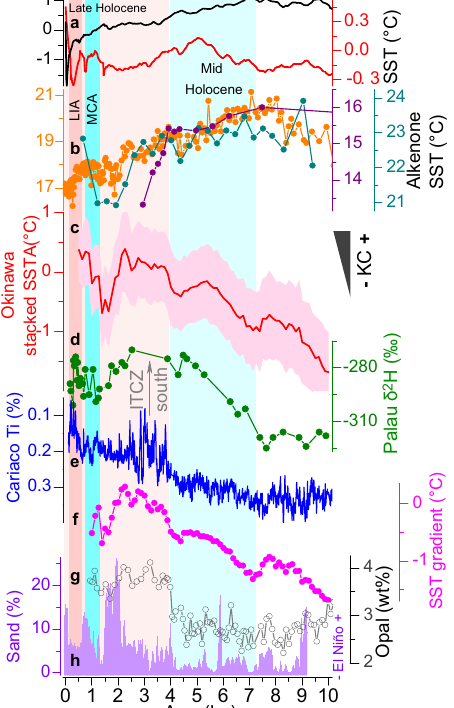
Fig. 4 Comparison of Kuroshio Current (KC)/North Paci fi c Subtropical Gyre circulation and tropical Paci fi c climate. a stacked sea surface temperature (SST) anomaly 34 over the Northern Hemisphere mid-latitudes (30 °N – 90 °N, black) and tropics (30 °N – 30 °S, red), ( b ) U K 0 across the Kuroshio Extension and Kuroshio-Oyashio Interfrontal Zone, including core site 8 78 (cyan), site 9 79 (orange), site 10 48 (purple), ( c ) stacked SST anomaly (with one standard deviation error) along the KC path, ( d ) lipid compound-speci fi c δ 2 H record in Palau lake sediment 23 , ( e ) Cariaco Ti record 75 , ( f ) the meridional SST gradient as shown in Fig. 2d, ( g ) opal content at site 13 39 and ( h ) sedimentary sand-based El Niño frequency from Galápagos lake (in the eastern Paci fi c) 22 . Colorful bars de fi ne the same intervals as shown in Fig.